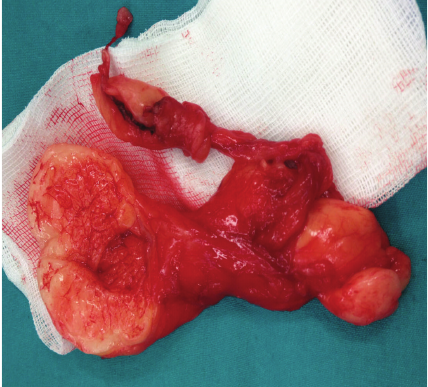
Figure 2: Fatty tissue that was completely excised.